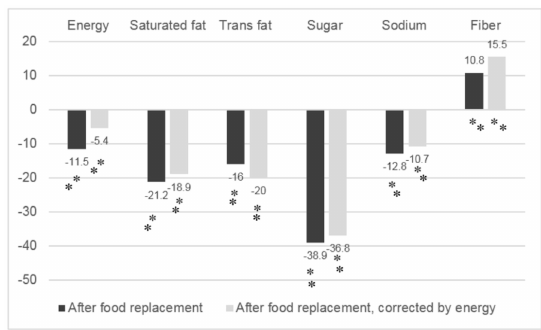
Figure 1. Median change of nutrient intake at national level after simulation of food replacement in the diet of the Mexican adult population (%) with FOP nutritional labeling criteria of the Mexican Committee of Nutrition Experts; * p >